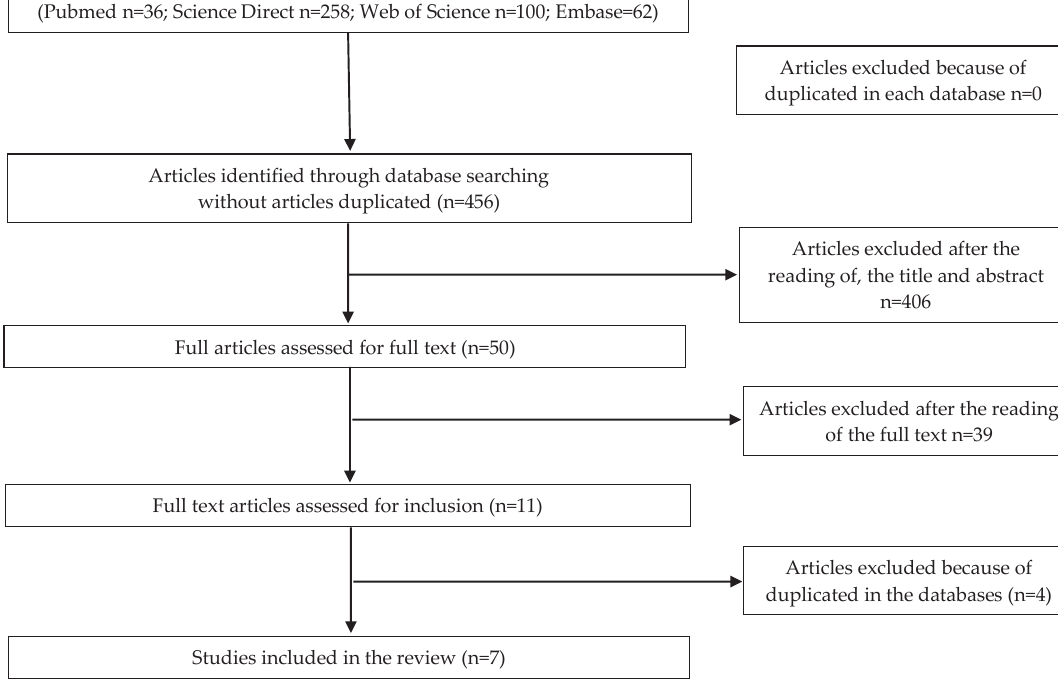
Figure 3. PRISMA (Preferred Reporting Items for Systematic reviews and Meta-Analyses) selection for chemical risk.